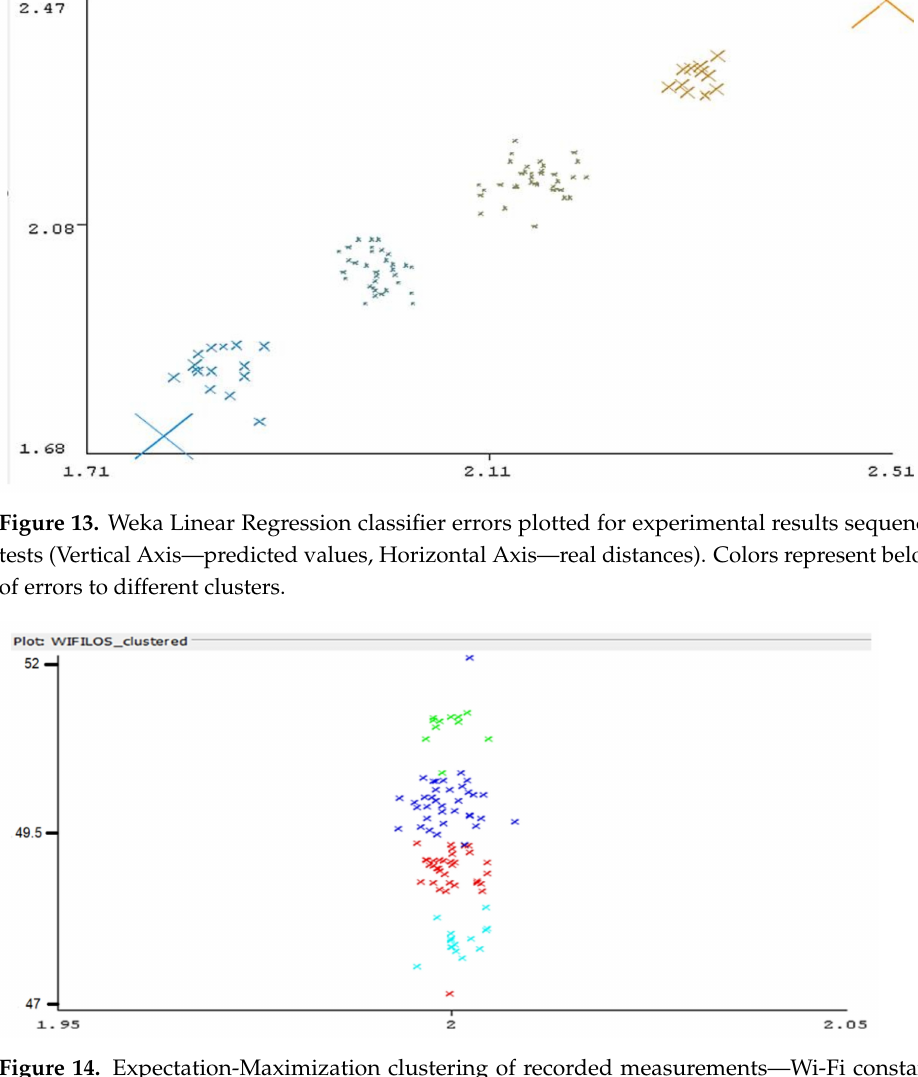
Figure 14. Expectation-Maximization clustering of recorded measurements—Wi-Fi constancy of received signal strength information, LoS condition—colors represent grouping of recorded values performed by the EM algorithm (horizontal axis: distance to AP, vertical axis: RSS